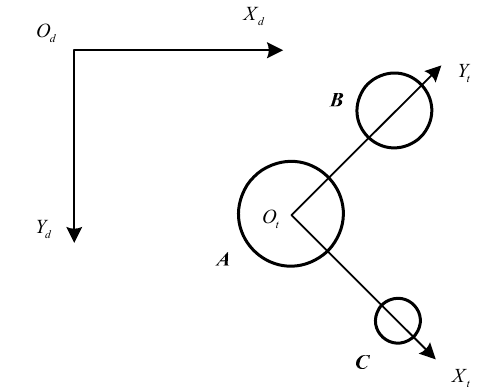
Fig. 7 Establishment of the target coordinates